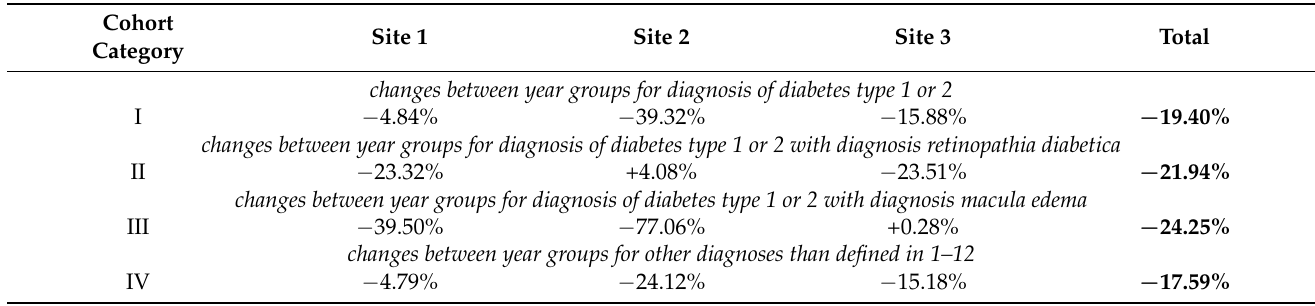
Table 3. Quantitative changes in diagnosis numbers between pre-pandemic (year 2018 + 2019) and pandemic (year 2020 + 2021) by cohort category and site.